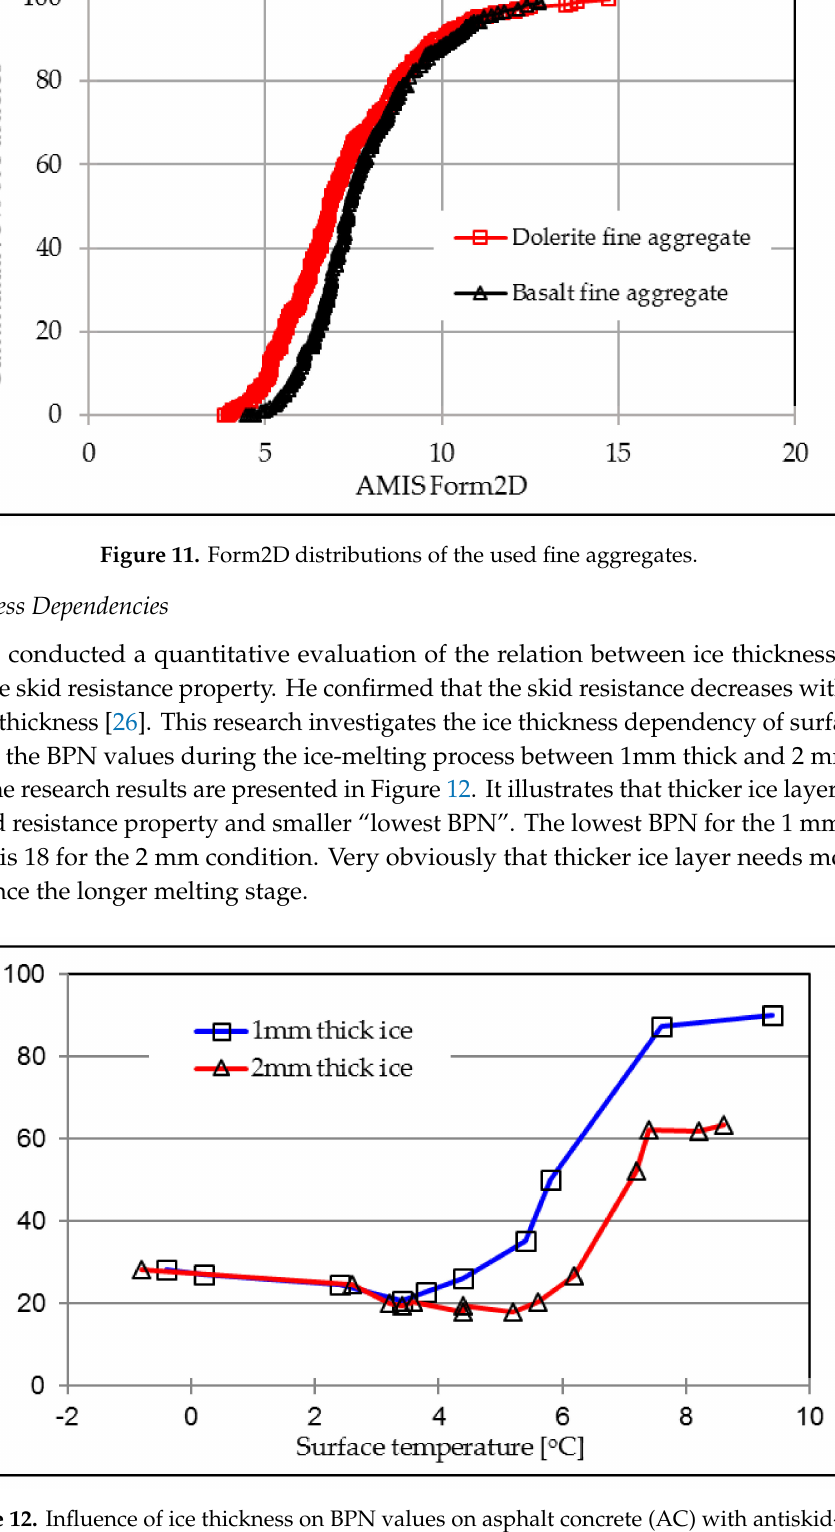
Figure 12. Influence of ice thickness on BPN values on asphalt concrete (AC) with